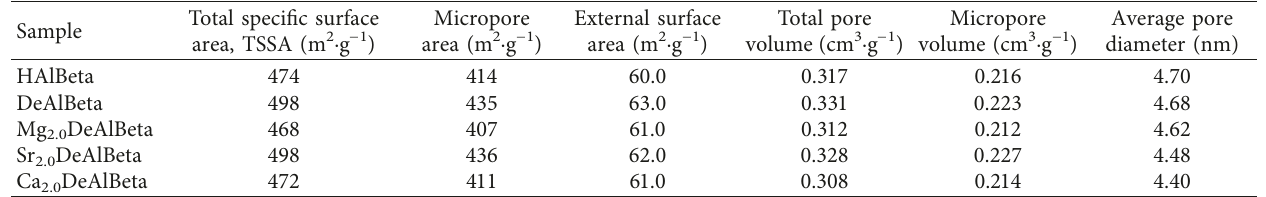
2 adsorption-desorption method.